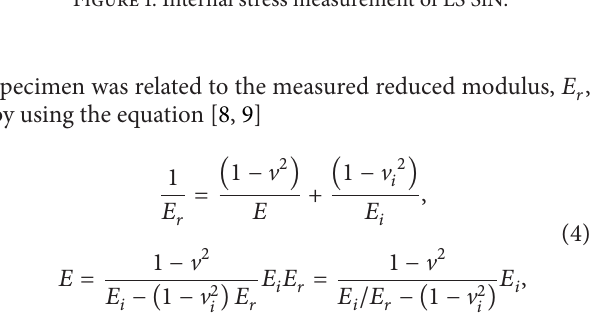
Figure 1: Internal stress measurement of LS